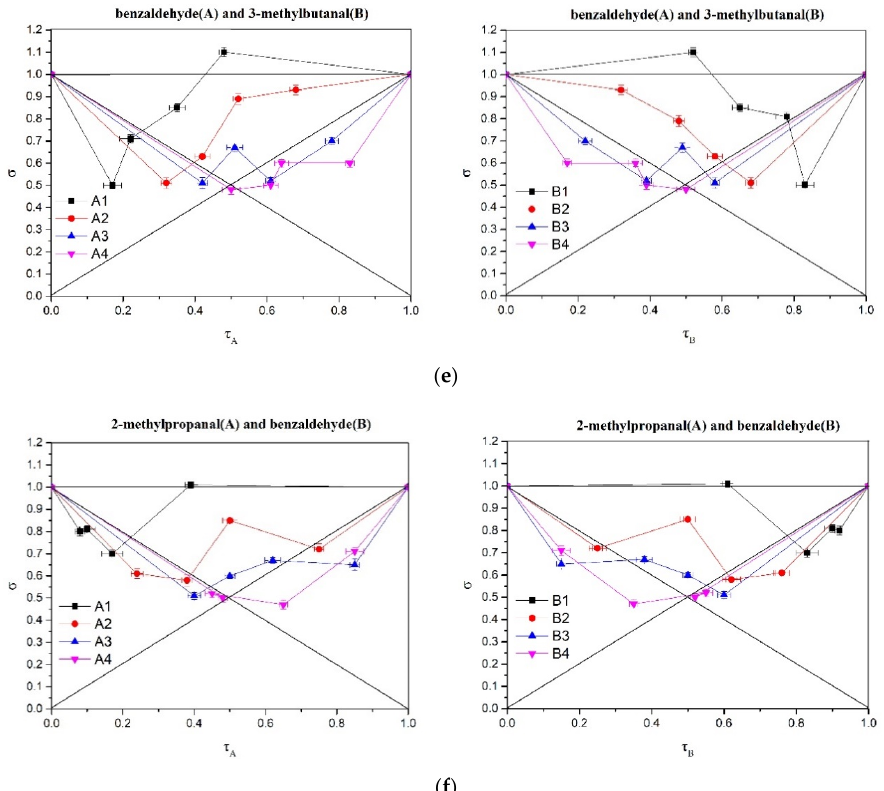
Figure 4. σ - τ diagram representations of seven pairs of binary mixtures. τ refers to the ratio of the perceived intensity of the binary mixture to the sum of the perceived intensities of the individual components before mixing. σ refers to the ratio of the perceived intensity of the mixture to the sum of the perceived intensities of each single component and reflects the level of various interactions. ( a ) 3-methylbutanal and 2-methylbutanal, ( b ) 2-methylbutanal and 2-methylpropanal, ( c ) 2-methylbutanal and benzaldehyde, ( d ) 2-methylpropanal and 3-methylbutanal, ( e ) 3-methylbutanal and benzaldehyde, ( f ) 2-methylpropanal and benzaldehyde pair. A1–A4 represents four concentrations of compound A from low to high. B1–B4 represent four concentrations of compound B from low to high. Error bars indicate 95% confidence intervals of the means for both τ and σ .